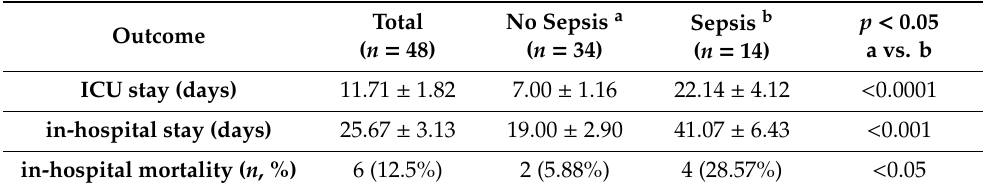
Table 3. Outcome of the study population. Data are given as mean ± standard error of the mean; p < 0.05. Abbreviations: a, no sepsis group; b, sepsis group; ICU, intensive care